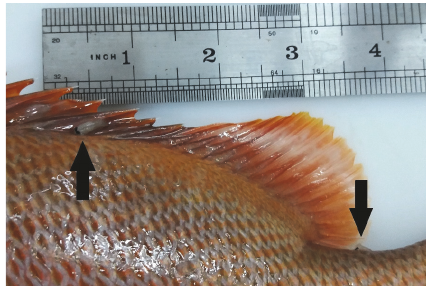
Figure 5: Excorallana richardsoni adhered to the body surface of Lutjanus jocu acquired from artisanal fishermen between the years of 2015 and